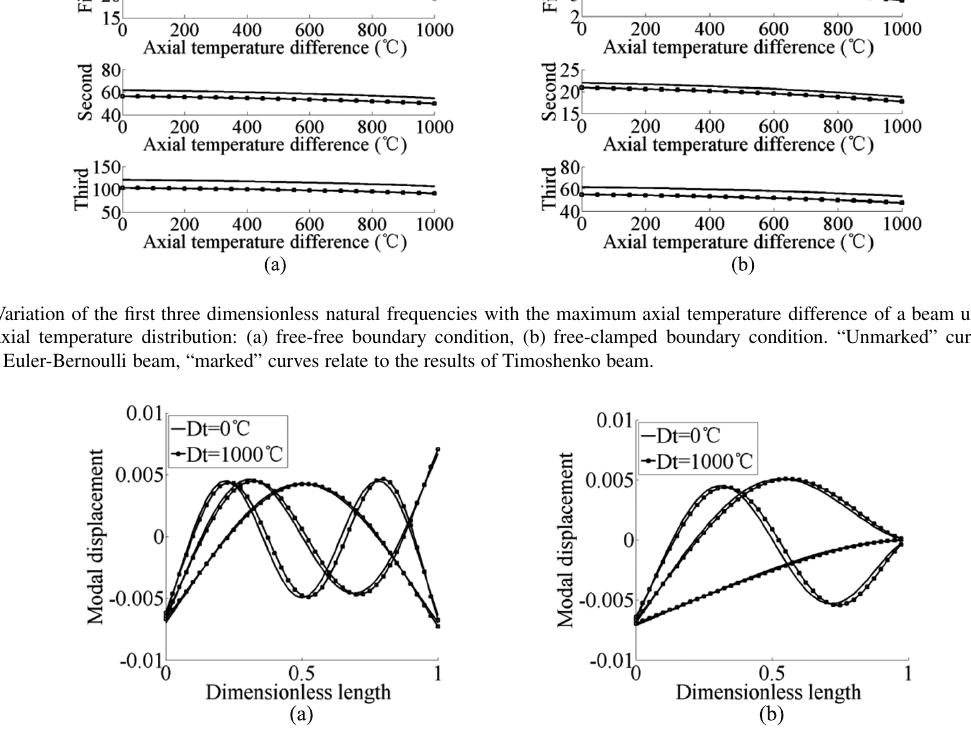
Fig. 14. The comparison of first three modal shapes under 0 axial temperature difference and 1000 ◦ axial temperature difference: (a) free-free boundary condition, (b) free-clamped boundary condition. second and third modal shapes is